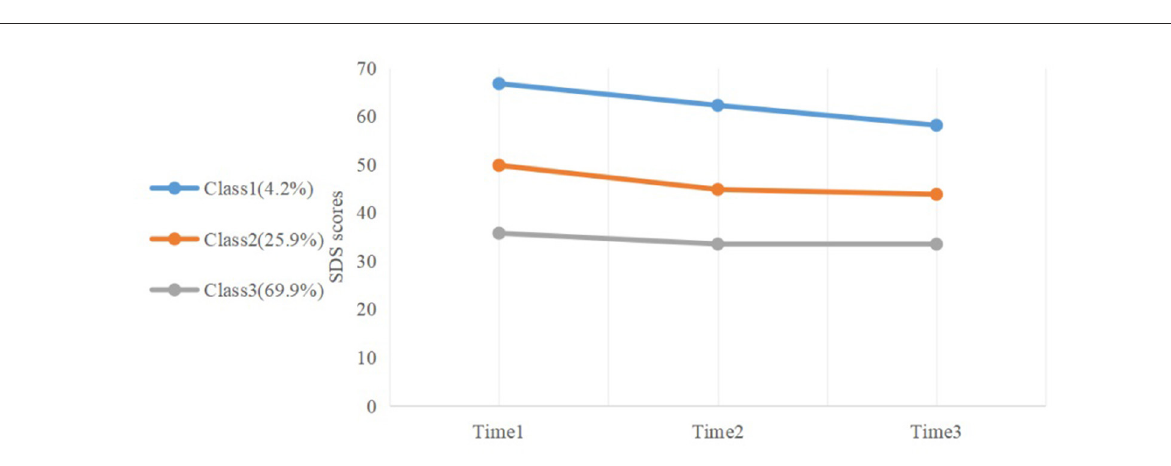
as “Moderate depressive symptom” (25.9%), and class 3